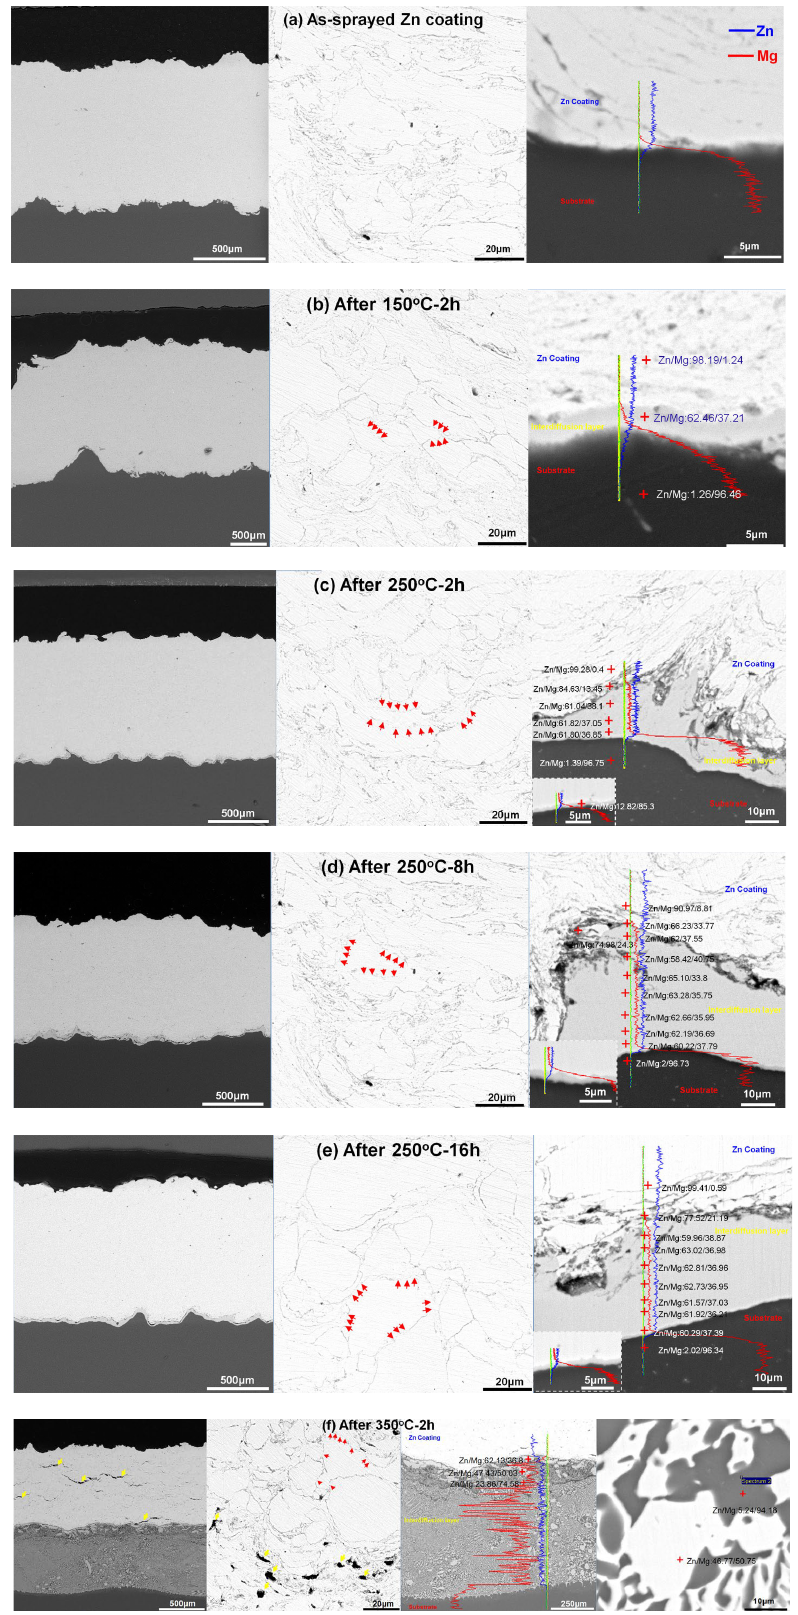
Figure 2. Cross-sectional microstructures of Zn coatings after different heating conditions. Red line: Mg K α 1-2; Blue line: Zn K α 1 ; Green line: Al K α 1 .; Yellow line: EDS scan trace. There were obvious inter-diffusion layers between Zn coatings and the Mg alloy substrate. The formation of a diffusion layer is reported for a Mg alloy brazed joint using Zn-based filler metal [21,22,31–33]. The thickness of the inter-diffusion layer was increased with the heat temperature and was slightly increased with the heat time as shown in Figure 3. In addition to the different thicknesses of inter-diffusion layers, there were significant differences between the diffusion layer/Zn coating interface and the diffusion layer/Mg alloy substrate interface. The different diffusion coefficient between the Zn atom and the Mg atom results in the formation of pores and microcracks at the side of Zn coatings [23,24]. At the diffusion layer/Zn coating interfaces, some pin pores and microcracks were observed at a heat temperature higher than 150 °C. While the diffusion layer/substrate interfaces show uniform and dense microstructures without any pores and microcracks, EDS scan lines show distributions of the Zn and Mg atoms at the Zn coating/diffusion layer/Mg alloy substrate interfaces, as shown in Figure 2. It can be found that the content of the Zn atom gradually decreased from the Zn coating to the